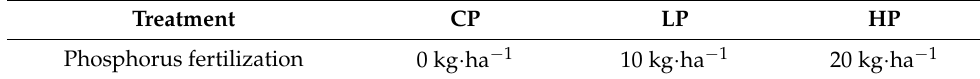
Table 1. Amount of phosphorus fertilization applied to Bupleurum